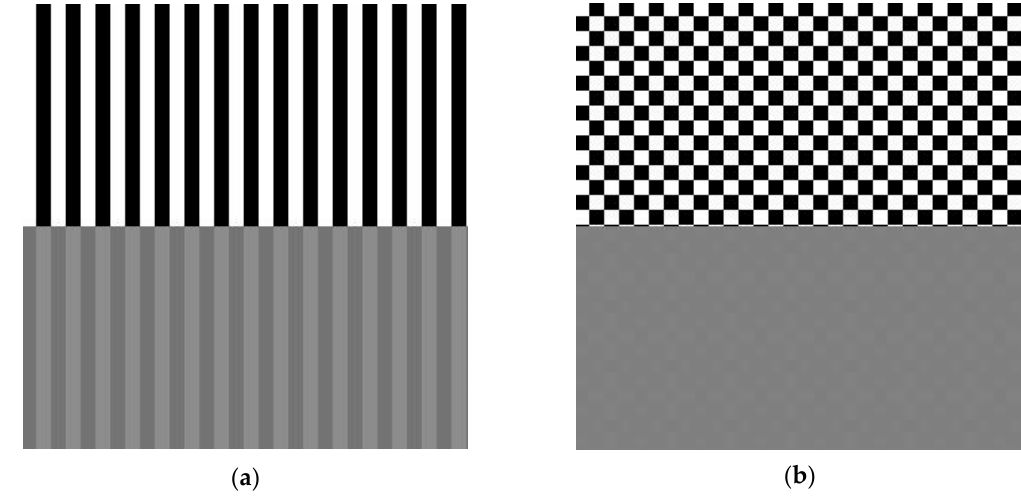
Figure 3. Uniformness simulation results. ( a ) Conventional 1D modulation; ( b ) Improved 2D modulation.